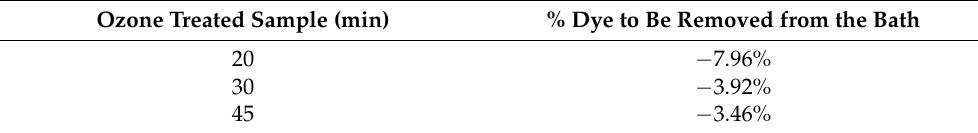
Table 4. Correction of the dyeing bath in % of dye to be removed.